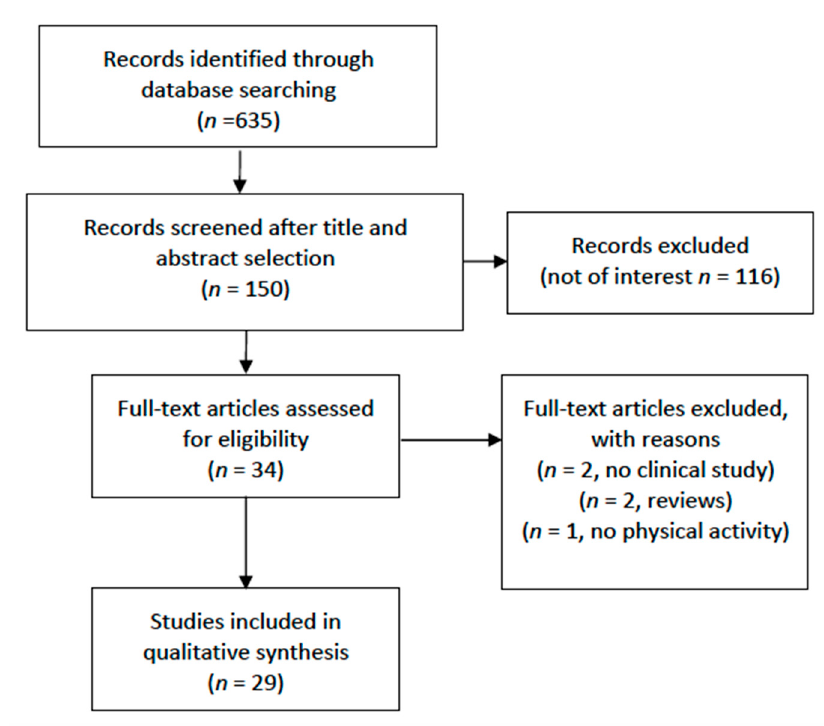
Figure 1. Flow chart of the inclusion process.